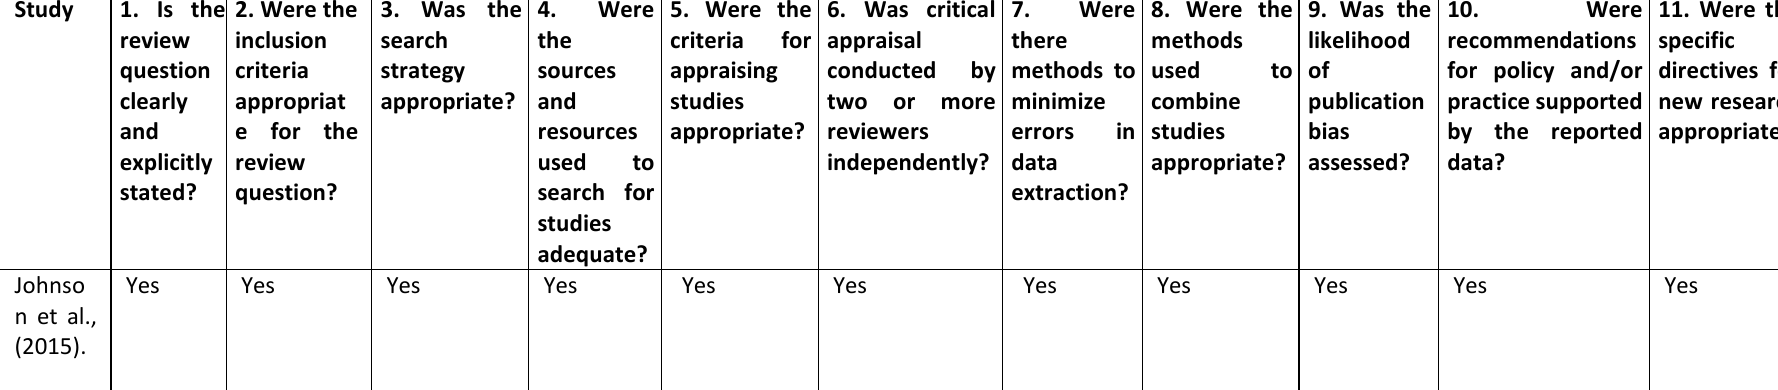
TABLE 6-A1: Critical appraisal of systematic review and research syntheses.